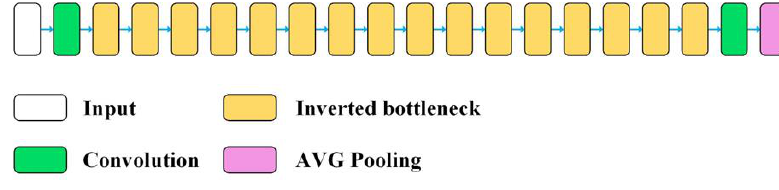
Figure 5. Structure of the MobileNetV2 network model [47].